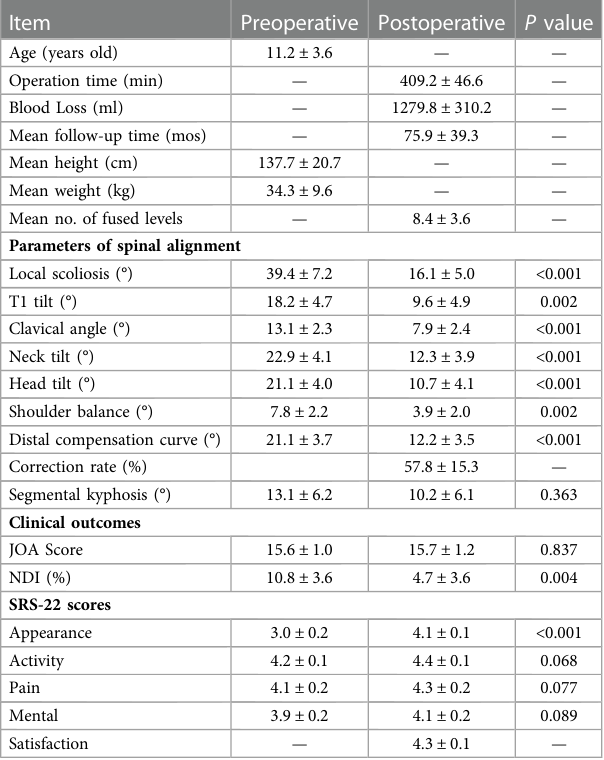
TABLE 3 Clinical evaluations in type II patients (mean±SD). Item Preoperative Postoperative P